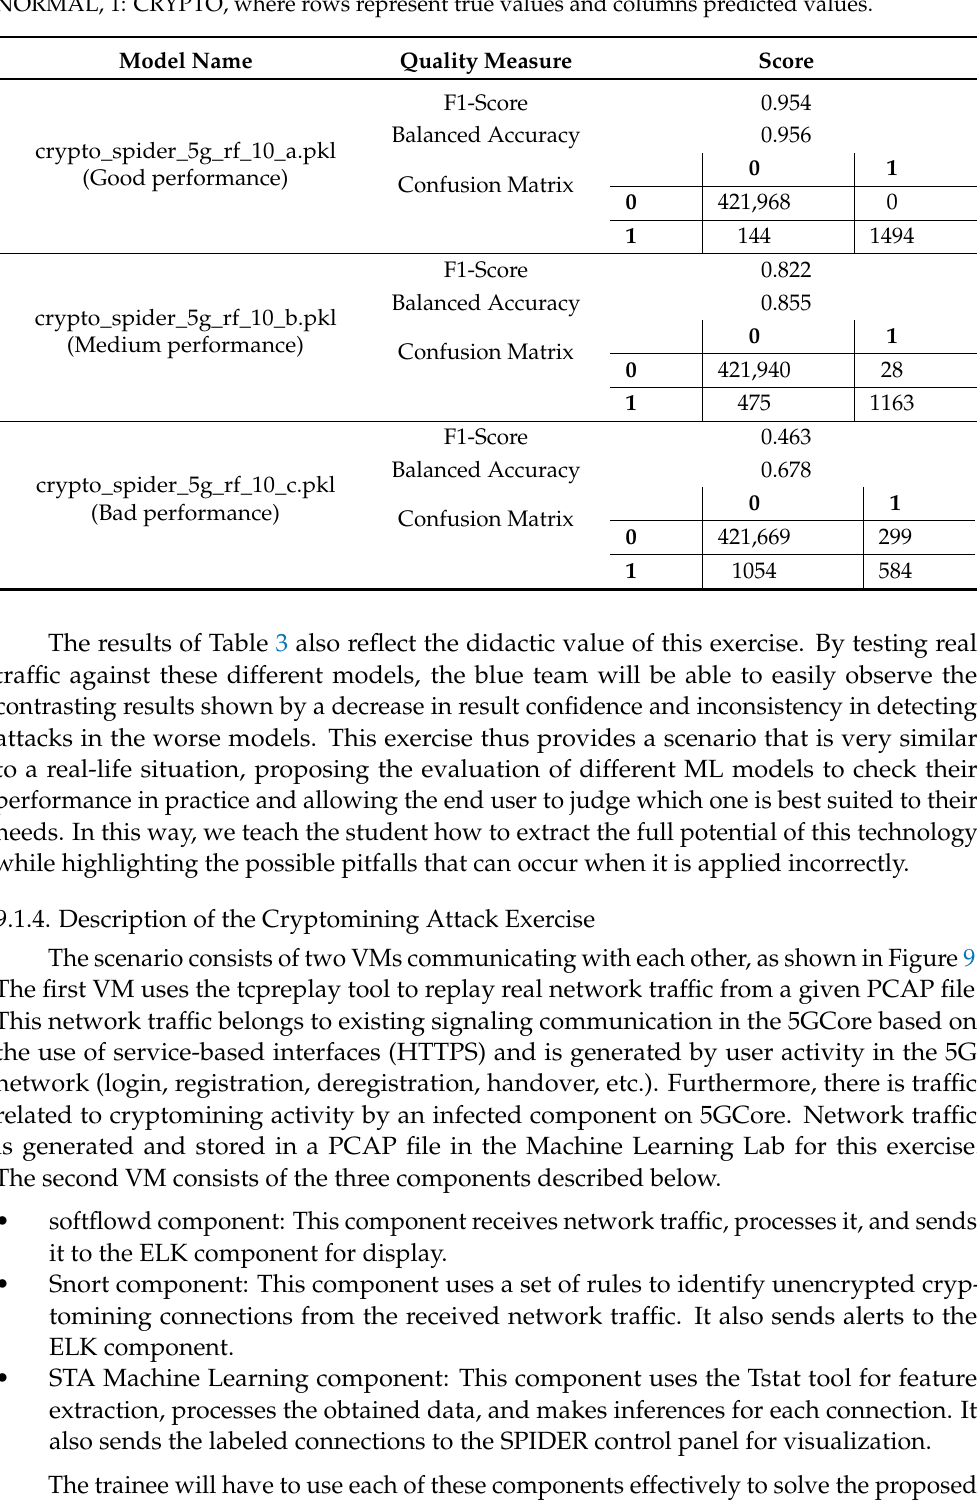
Table 3. Quality measures of cryptomining traffic classification models. In the confusion matrices 0: NORMAL, 1: CRYPTO, where rows represent true values and columns predicted